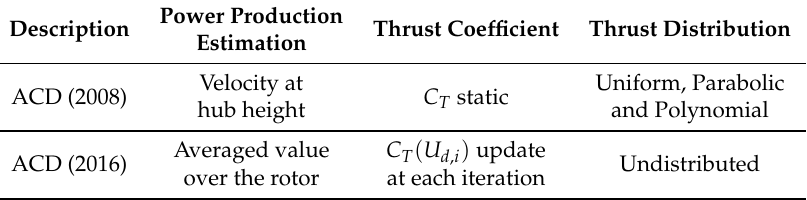
Table 1. Main differences between the ACD (2008) and the ACD (2016)